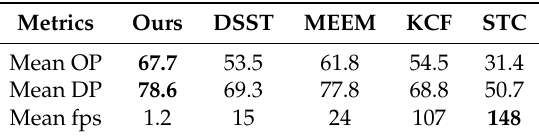
Table 1. Comparison with state-of-the-art trackers on the OTB100 dataset. The results are presented in terms of mean overlap precision (OP) (%) at an overlap threshold of 0.5, DP (%) at a threshold of 20 pixels, and fps. The optimal results are highlighted in bold.